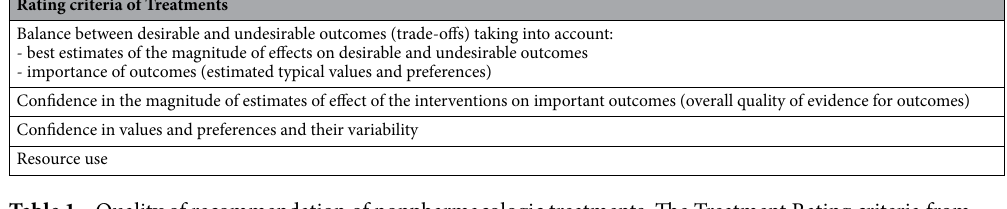
Table 1. Quality of recommendation of nonpharmacologic treatments. The Treatment Rating criteria from